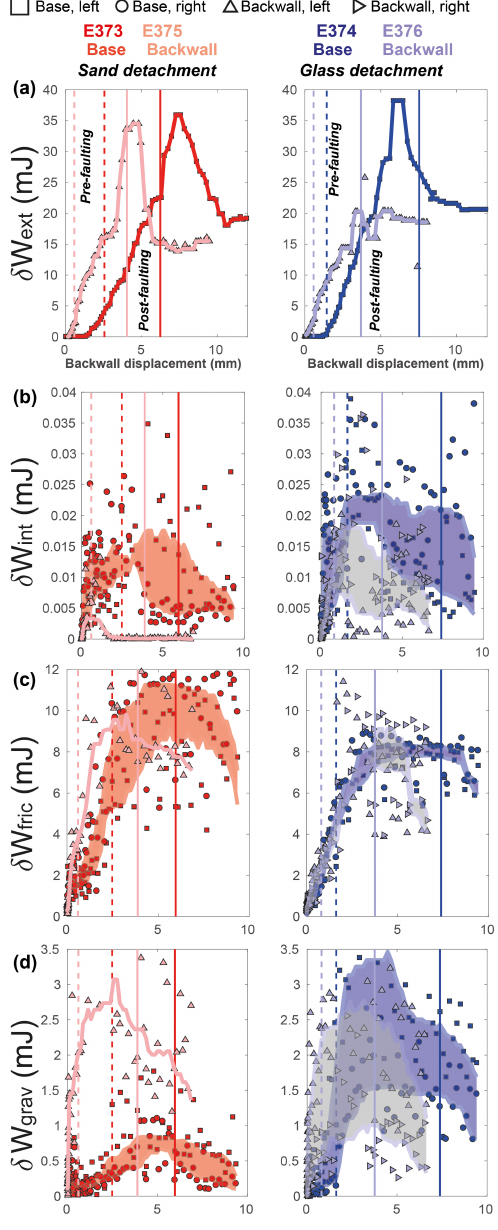
Figure 4. Incremental work budget components throughout the de- velopment of the first thrust pair for experiments with the sand de- tachment (left column) and glass detachment (right column). (a) In- cremental external work, δW ext . (b) Incremental internal work, δW int . (c) Incremental frictional work, δW fric . (d) Incremental grav- itational work, δW grav . Vertical dashed and solid lines show stages before and after fault development, respectively. We used the dis- placement fields observed on the left (upward-facing triangles and squares) and right (right-facing triangles and circles) sides of the box to calculate δW int , δW fric and δW grav . Shaded regions are bounded by curves that are 5-point (for δW ext ) or 20-point (for the other components) median filters through the data obtained from each work budget component. We use a smaller filter window for δW ext in order to capture fluctuations produced by variations in backwall force, which are lost with a 20-point median